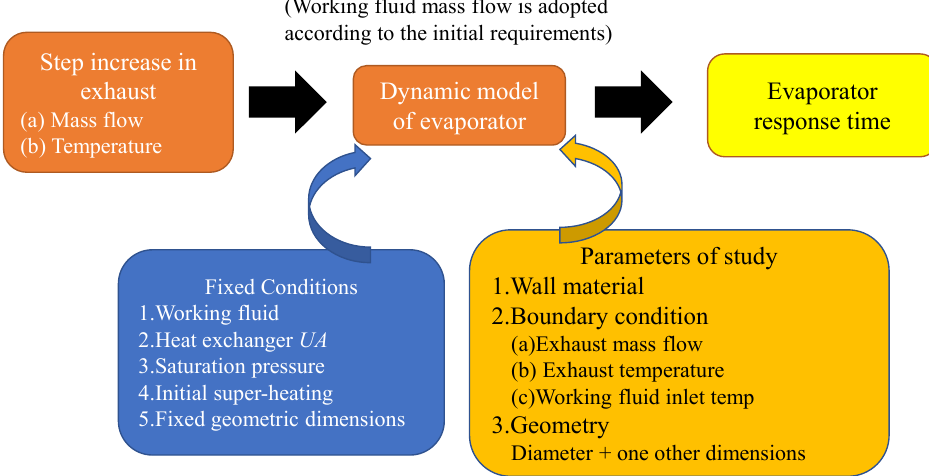
Figure 19. Summary of dynamic characterization methodology [85]. Reproduced with permission from Jiménez-Arreola et al., Applied Energy; published by Elsevier, 2018.